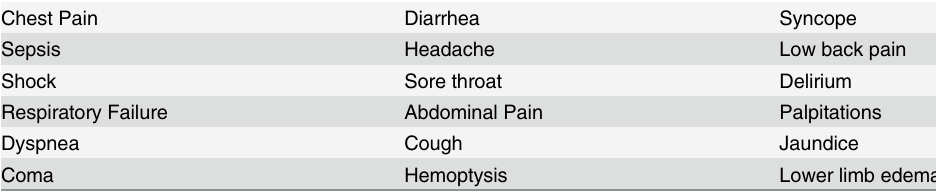
Table 1. Initial complaints that had their individual